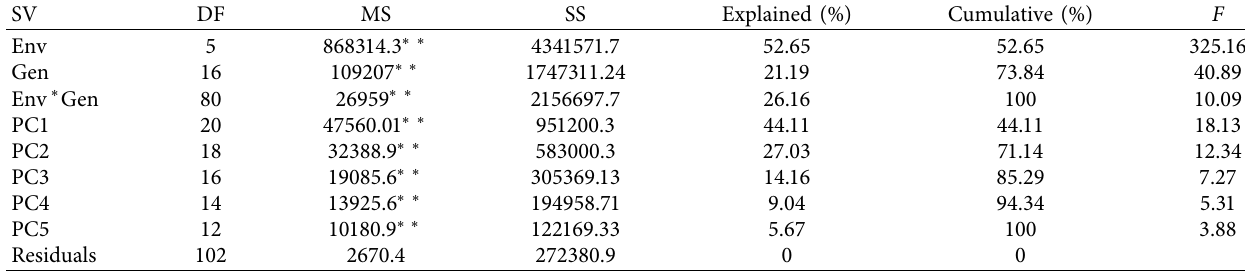
Table 4: AMMI analysis of variance for mean bean yield (kg ha − 1 ) of 17 coffee genotypes tested across six environments in 2016/17 and